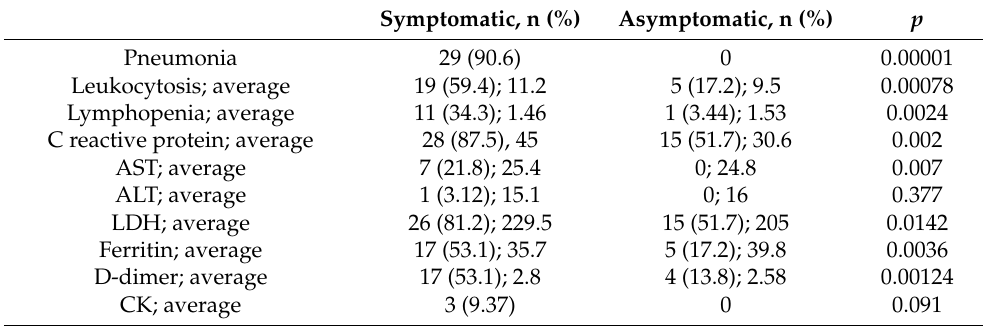
Table 2. Clinical and laboratory data in pregnant women with SARS-CoV-2 infection.